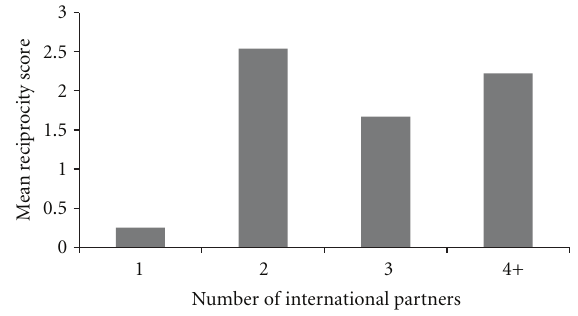
Figure 2: Average reciprocity score in relation to number of inter- national